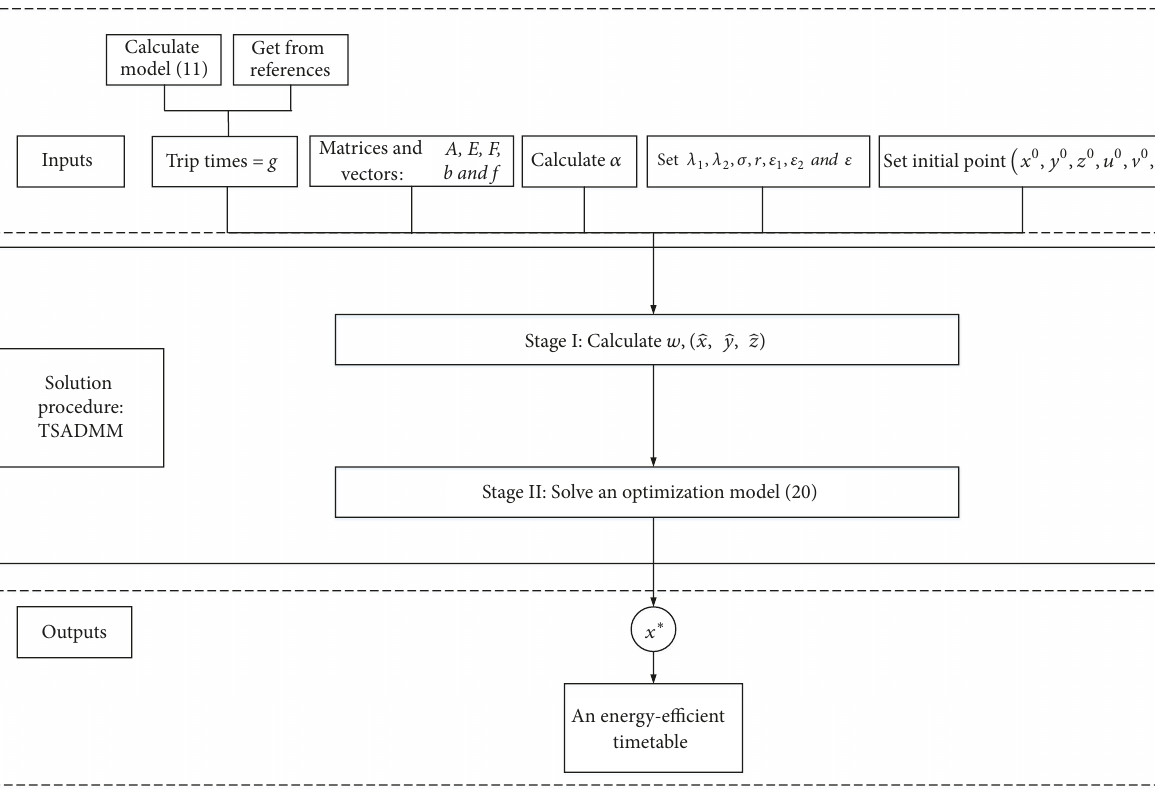
Figure 6: The procedure of the numerical